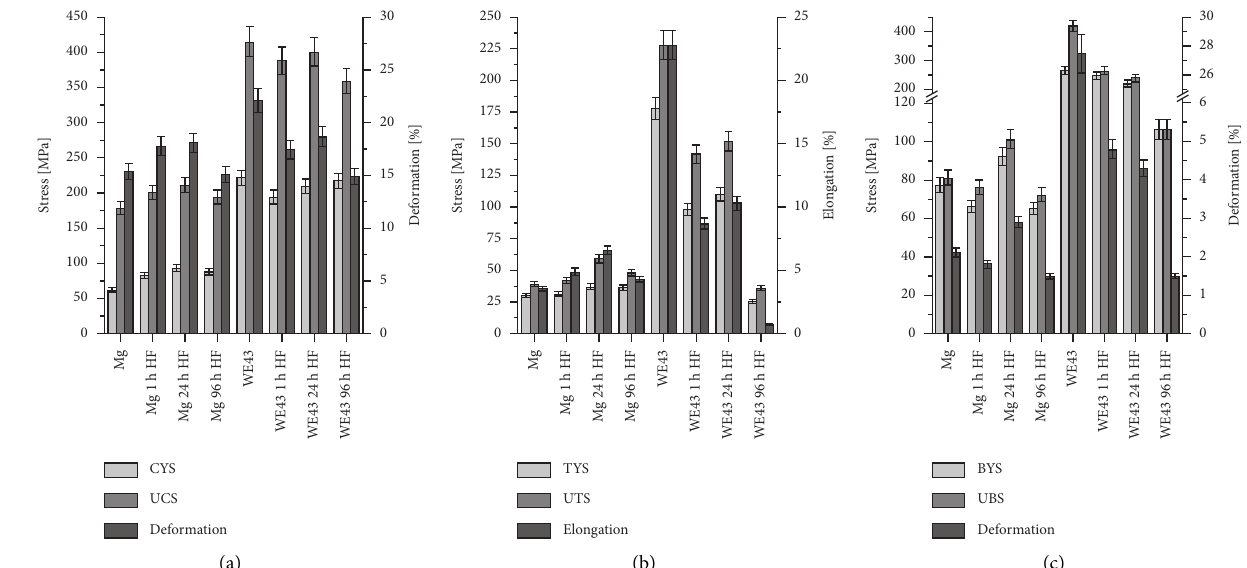
Figure 7: Mechanical properties of Mg and WE43 alloys: (a) compressive, (b) tensile, and (c) bending (compressive yield strength (CYS), ultimate compressive strength (UCS), tensile yield strength (TYS), ultimate tensile strength (UTS), bending yield strength (BYS), and ultimate bending strength (UBS))